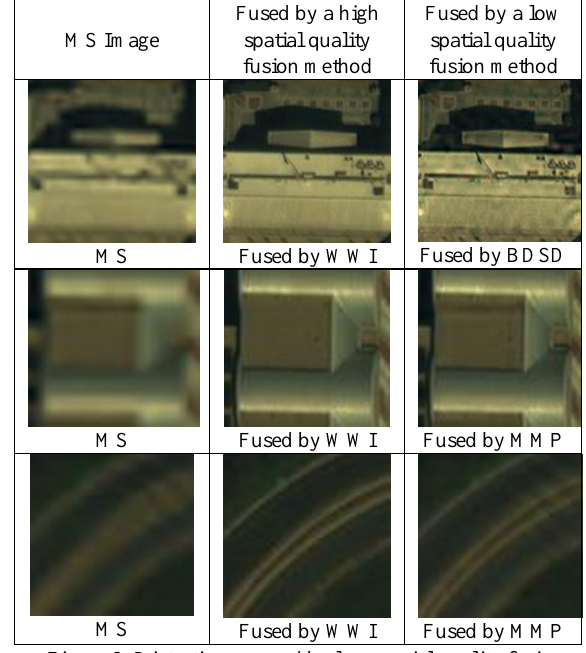
Figure 8. Distortions caused by low spatial quality fusion